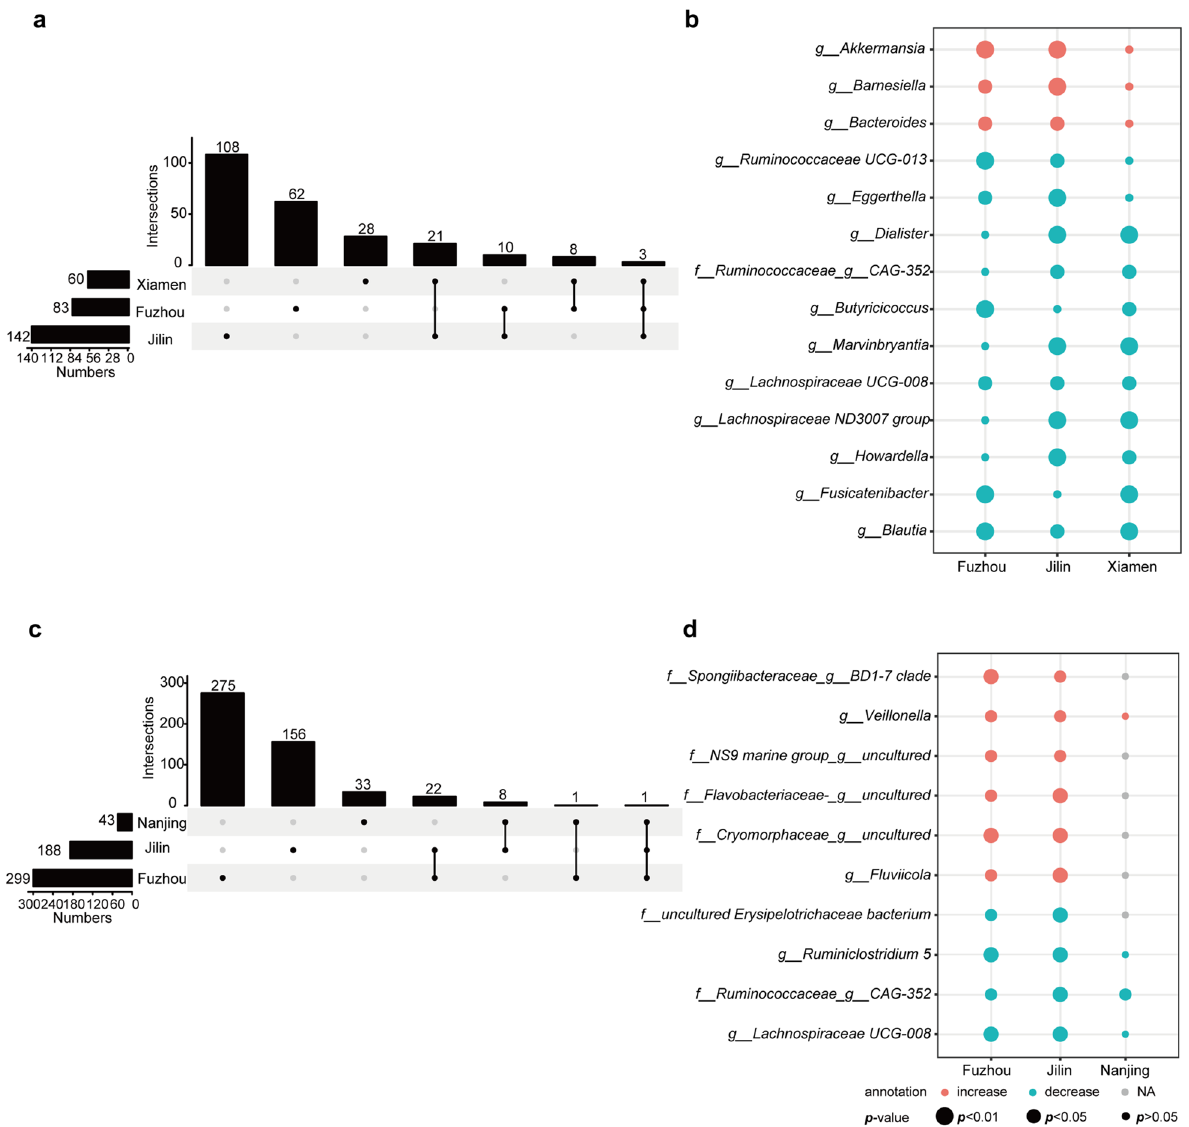
Fig. 3 The significantly differential genera between LC or HCC and HC across datasets. a – b UpSet plot and bubble plot of the significantly differential genera between LC and HC across datasets. c – d UpSet plot and bubble plot of the significantly differential genera between HCC and HC across datasets. Red and green represented the direction of differential genera, the shape size represented the significant level. NA, not detected